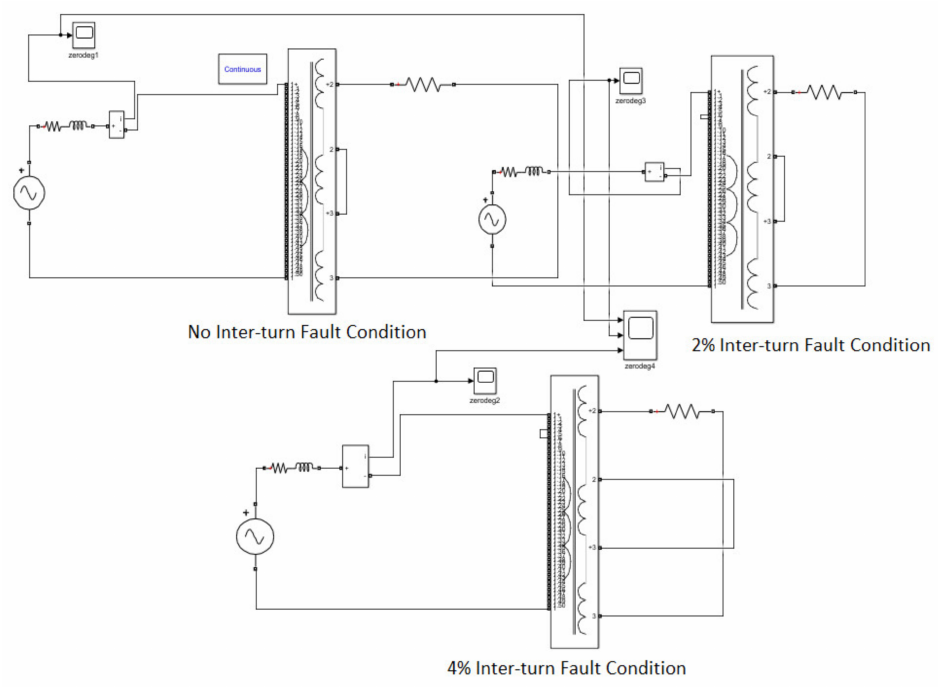
Figure 12. Simulink model for various transformer internal (turn-to-turn) faults (no fault, 2% fault and 4% fault).